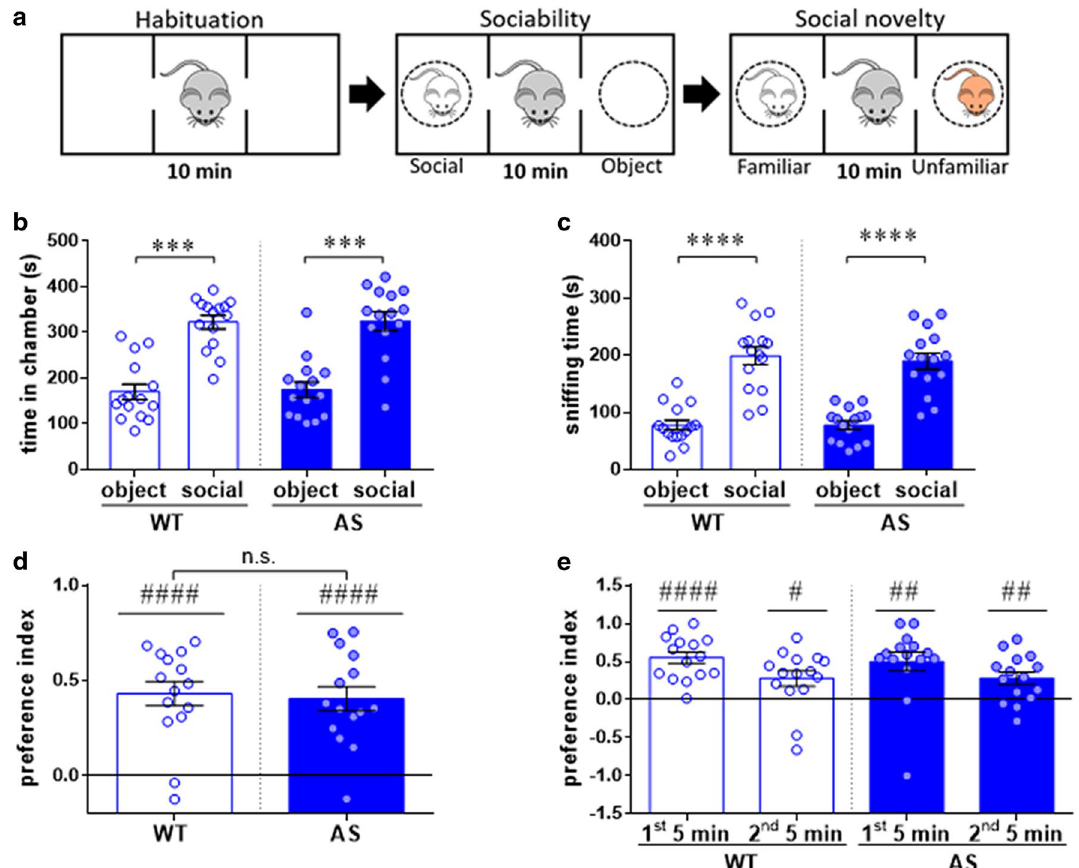
Figure 1. AS male mice do not display aberrant sociability in the three-chamber social test. ( a ) Illustration of sociability and social novelty tests. ( b ) Time spent in the chamber containing the novel mouse (‘social’) and the chamber containing the empty wire cage (‘object’). Both genotypes exhibit enhanced exploration of the social chamber. ( c ) Sniffing time of the novel mouse and the empty wire cage. Both WT and AS mice spend more time sniffing the social stimulus (novel mouse). ( d ) Social preference index (PI) towards the social stimulus. WT and AS mice exhibit a comparable social PI. ( e ) Social PIs are binned into 5-min bins. Both genotypes maintained positive social PI along the entire trial. Bar graphs represent mean ± SEM. N = 15 mice per each group (WT and AS). *** p < 0.001,**** p < 0.0001, n.s. = non-significant; # p < 0.05, ## p < 0.01, #### p < 0.0001 represent a difference from chance